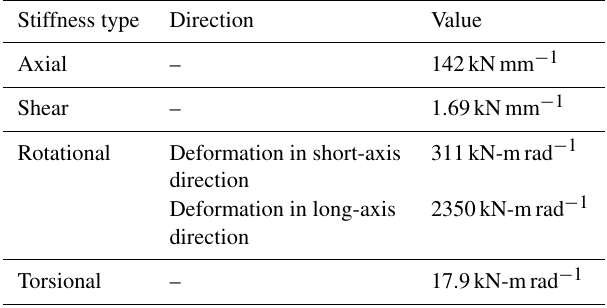
Table 4. OpenSees elastomeric bearing spring